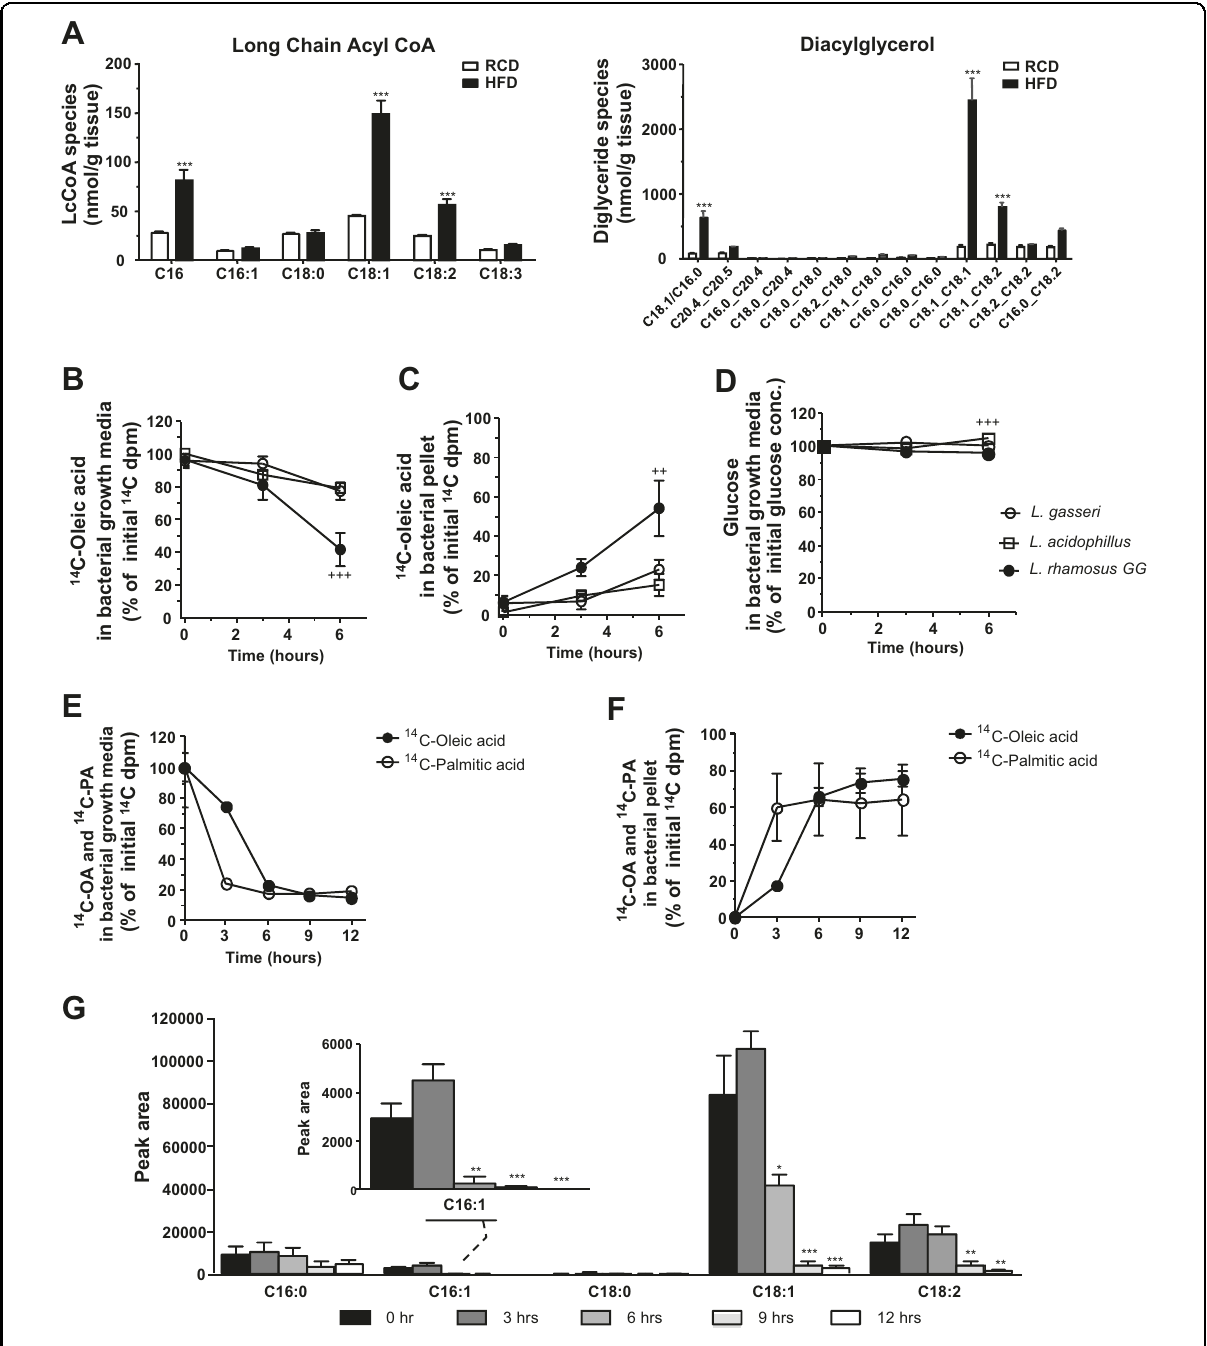
Fig. 1 Lactobacillus rhamnosus GG consumes exogenous fatty acids. a Diet-dependent hepatic long-chain acyl CoA (left panel) and diacylglycerol (right panel) ( n = 6 per group). [ 14 C]-OA radioactivity measured in b bacterial growth media and in c bacterial pellets. d Percentage of glucose concentration measured in bacterial growth media. [ 14 C]-OA and [ 14 C]-PA radioactivity measured in e bacterial growth media and in f bacterial pellets. g Relative peak area of fatty acids detected in the growth media after 0, 3, 6, 9, and 12 h of incubation of L. rhamnosus GG ( n = 6 per group). Data are expressed as the mean ± SEM from three independent experiments. ++ P < 0.01 and +++ P < 0.001 for the difference between L. rhamnosus GG and others by two-way ANOVA and ** P < 0.01 and *** P < 0.001 by one-way ANOVA with post hoc analysis